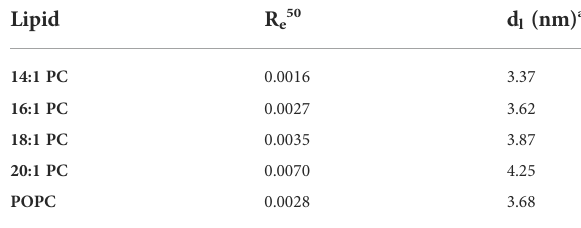
TABLE 1 The mole ratio of membrane-bound tolaasin molecules per membrane lipid needed to trigger 50% calcein leakage (R e 50 )